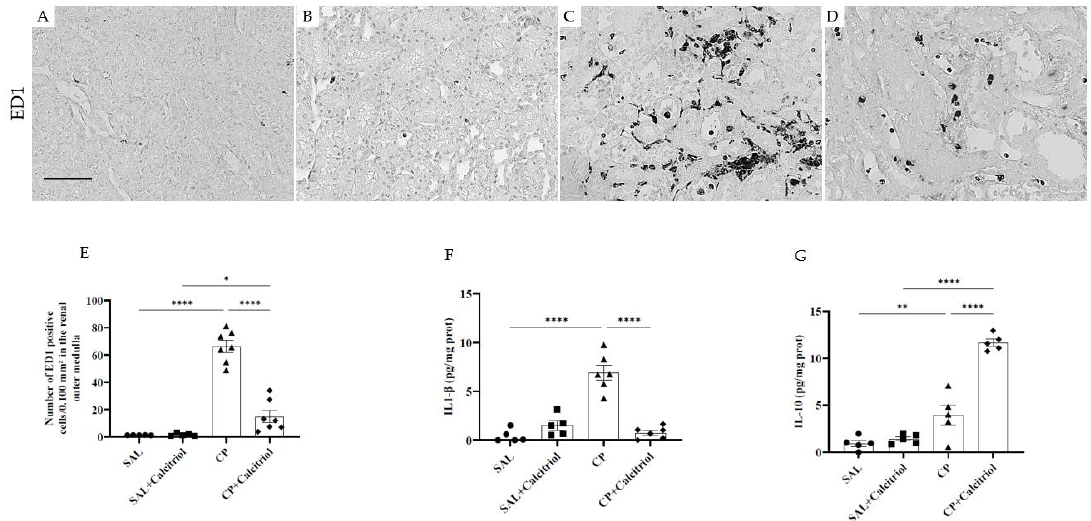
Figure 3. Immunolocalization of ED1-positive cells (macrophages) in the outer renal medulla of the SAL ( A ), SAL + calcitriol ( B ), CP ( C ) and CP + calcitriol ( D ) groups (bar represents 50 μm). The number of ED1-positive cells in all experimental groups ’ outer renal medulla ( E ). Values are given as the mean ± SEM. Renal tissue levels of IL (interleukin)- 1β ( F ) and IL (interleukin)-10 ( G ) from control (SAL and SAL + calcitriol) and experimental (CP and CP + calcitriol) groups. Data are expressed as mean ± SEM ( n = 5 – 8 for each group). * p < 0.05; ** p < 0.01; **** p < 0.0001: magnification, ×400.